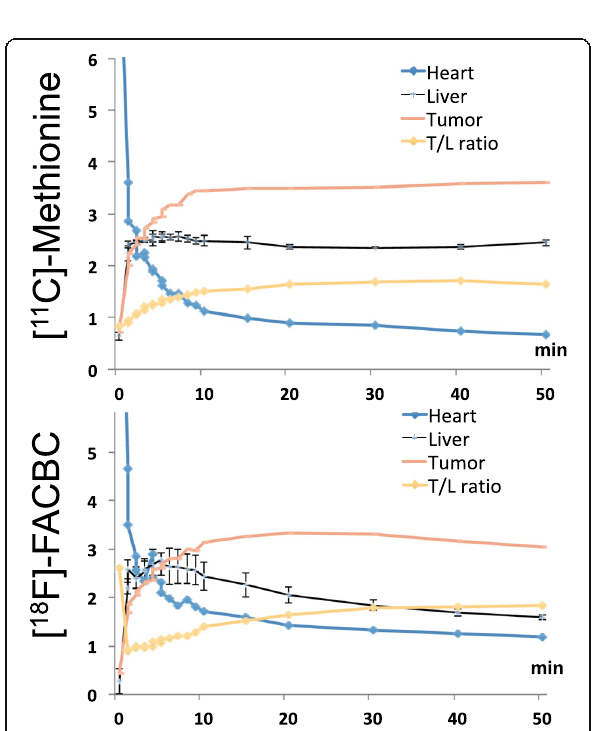
Fig. 6 Regional time activity curves (in SUV) generated from the dynamic PET scans of the same animal with [ 11 C]Met and [ 18 F]FACBC, respectively, along with their tumor to liver background (T/L) ratios